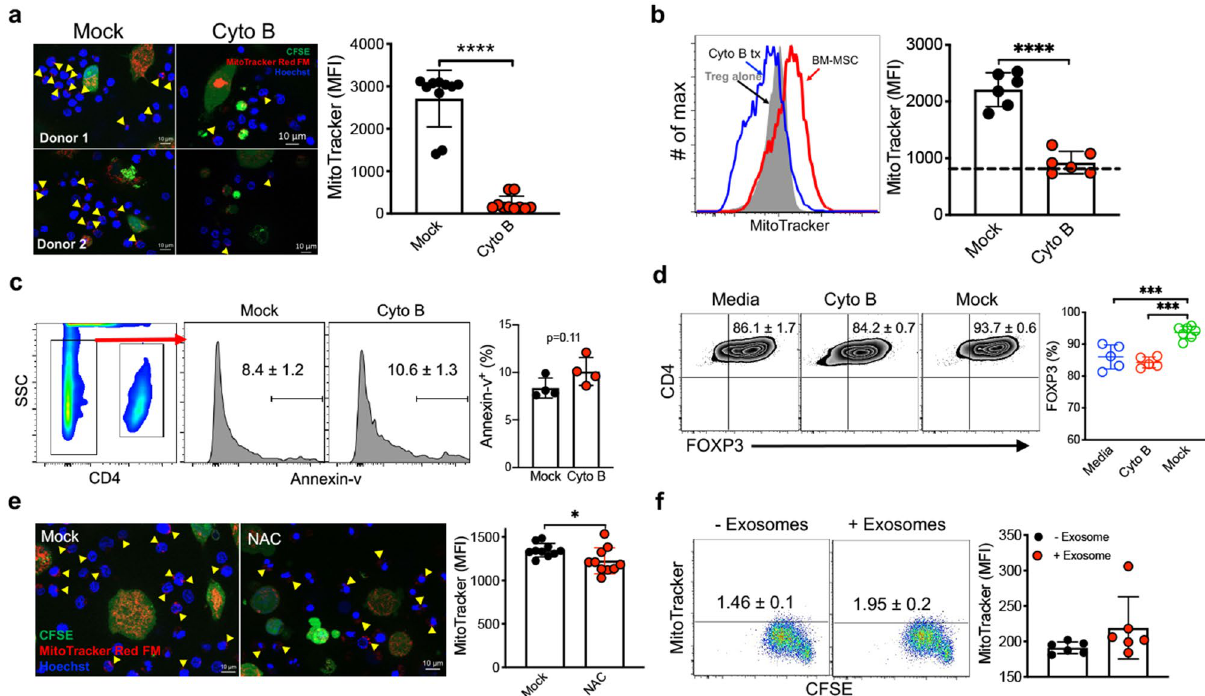
Figure 4. MSC-iTreg interactions are required for mt transfer. ( a ) Mitochondrial transfer measured in iTreg co-cultured with cytochalasin B treated MSC for 24–36 h ( n = 5). Cytochalasin B was added in the MSC co-culture (350 nM). Arrowheads indicate mt transfer to iTreg. Analysis of recorded images was performed using Zen 2012 software. ( b ) FACS analysis of MSC mt transfer to iTreg after cytochalasin B treatment. MSC were stained with MitoTracker Far Red (red) and iTreg were co-cultured for 48–72 h. iTregs were stained by CD4 antibody and analyzed. ( c ) Annexin V FACS analysis of MSC viability after cytochalasin B treatment. MSCs were gated as CD4 negative population. ( d ) FOXP3 expression in iTregs was measured from mock vs cytochalasin B treated MSC co-culture expanded iTregs ( n = 5–7). ( e ) Effect of ROS inhibitor treatment on mitochondrial transfer. MSC were pre-stained with CFSE and MitoTracker Red FM and then cultured with Hoechst stained iTreg for 24–36 h. The ROS inhibitor antioxidant N -acetylcysteine (NAC) 200 μM was added to MSC + iTreg culture for 24–36 h. Live cell images were collected by confocal microscopy. ( a , e ) Analysis of recorded images was performed using Zen software Blue edition, (2011; version 2.0.14283.302). https:// www. zeiss. com/ micro scopy/ us/ produ cts/ micro scope- softw are/ zen. html ( f ) MSC exosome uptake by proliferating iTregs. MSC exosome were stained with MitoTracker Far Red (Hough et al., 2018). FOXP3 + iTregs were stimulated with plate bound CD3 (1 μg ml −1 ) for 72 h. Data are representative of 2–3 independent experiments. * p < 0.05, *** p < 0.001, **** p < 0.0001 paired t test. Scale bars: 10 μm. See also Supplementary Figs. S4 and